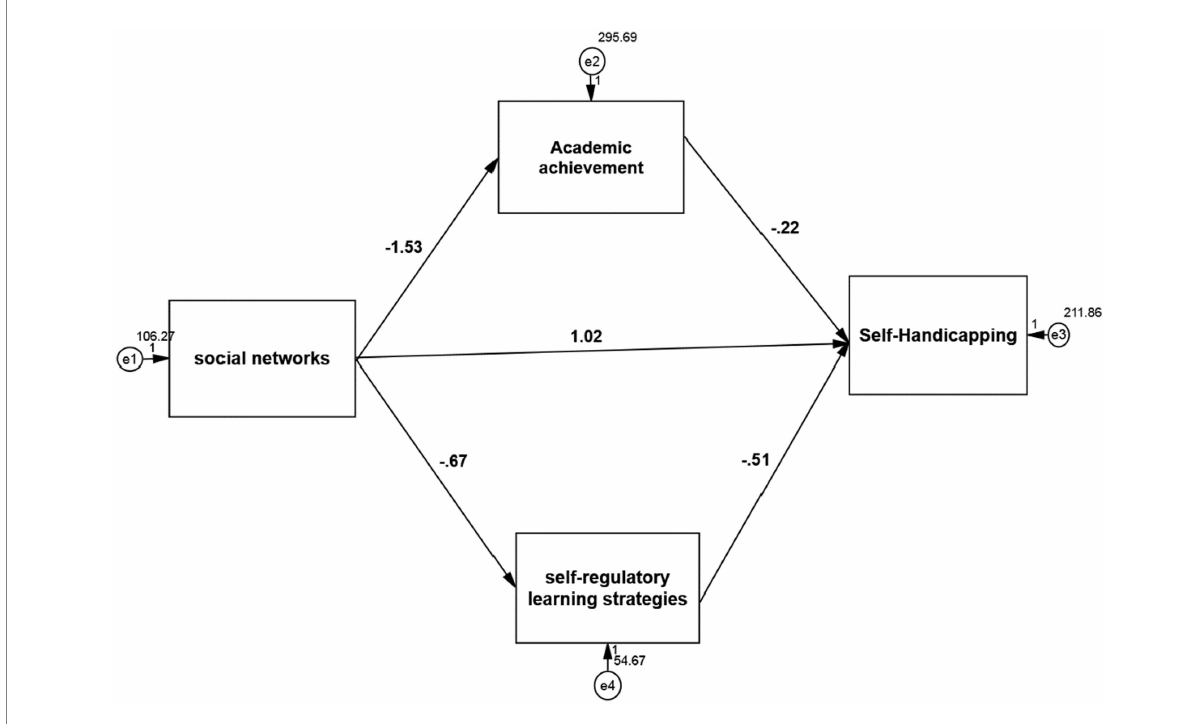
FIGURE 3 Model fit in non-standard estimation